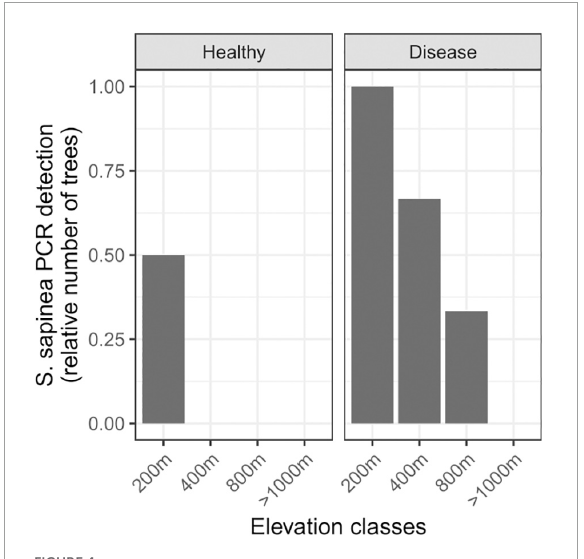
FIGURE4 Distribution of Sphaeropsis sapinea across an elevation gradient in the French Alps. PCR detection of S. sapinea across health status and elevation. Symptomatic needle samples: from 200 m above sea level (asl) ( n = 2), 400 m asl ( n = 3), 800 m asl ( n = 3), >1,000 m asl (up to 2,100 m asl, n = 20); asymptomatic needle samples: from 200 m asl ( n = 2), 400 m asl ( n = 2), 800 m asl ( n = 2), >1,000 m asl (up to 1,600 m asl, n =